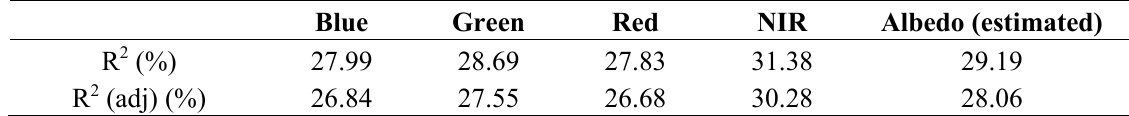
Table 5. Regression comparison (daytime).